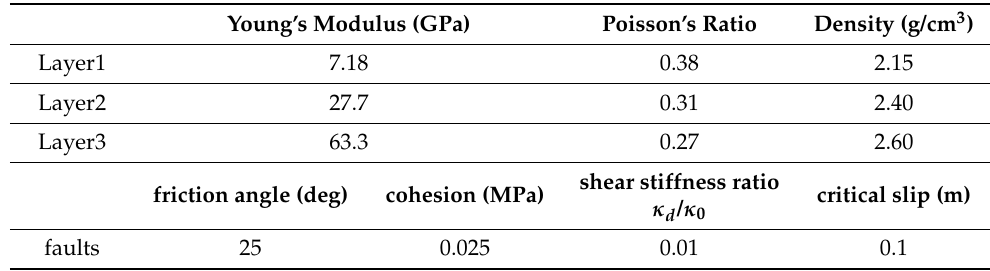
Table 1. Material